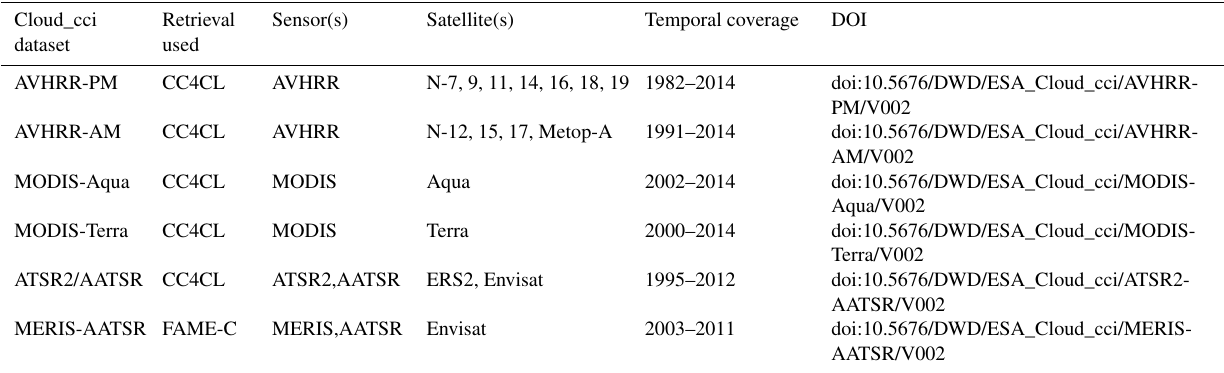
Figure 1. Overview of all sensors processed in Cloud_cci and their duration as a function of the daytime Equator-crossing time (AM: ante meridiem, before noon; PM: post meridiem, after noon). Sensors belonging to the same dataset are shown in the same colour. Table 1. List of Cloud_cci datasets together with the corresponding retrieval scheme, the sensor(s), satellite(s) used and the time period covered as well as the digital object identifiers (DOIs)